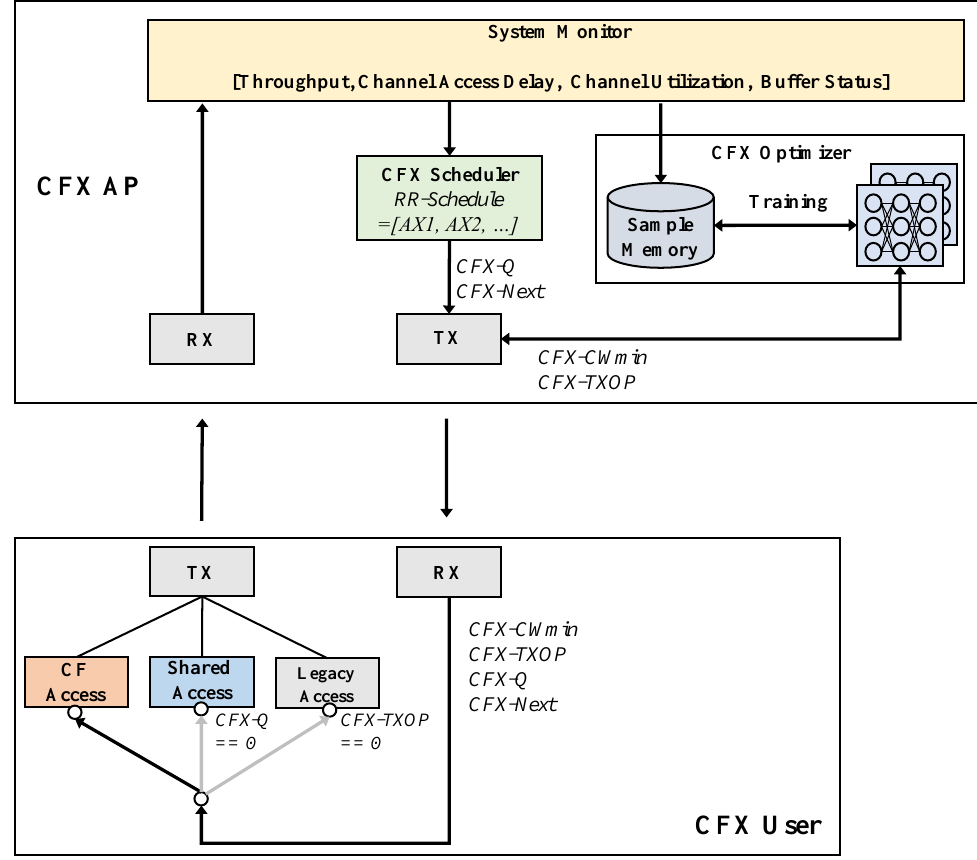
Figure 2. Architecture of CFX, consisting of three main components: CF channel access, shared channel access and the CFX